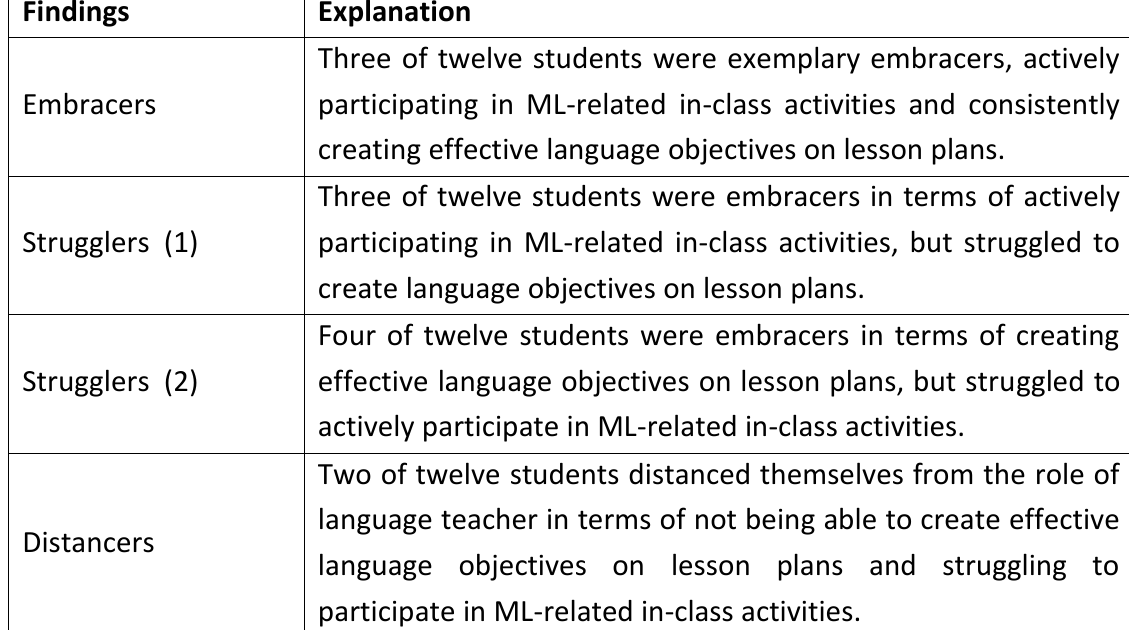
Figure 2: Embracing the Role of Language Teacher